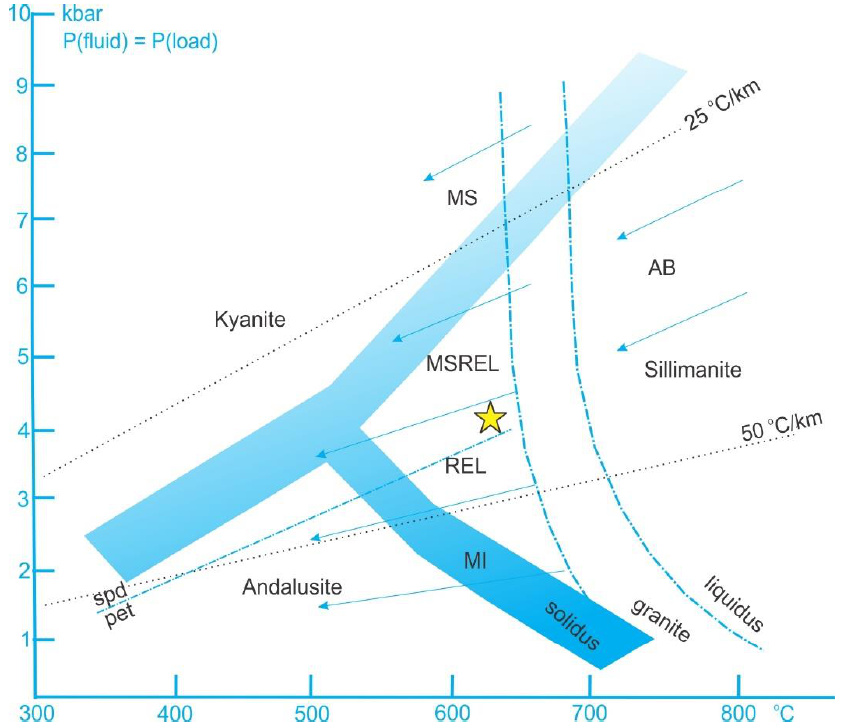
Figure 13. Schematic P-T fields of regional host rocks of five classes of granitic pegmatites: abyssal (AB), muscovite (MS), muscovite - rare-element (MSREL), rare-element (REL), and miarolitic (MI) (redrawn from [3]). Yellow star denotes the Yamrang Pegmatite in the REL pegmatite field.